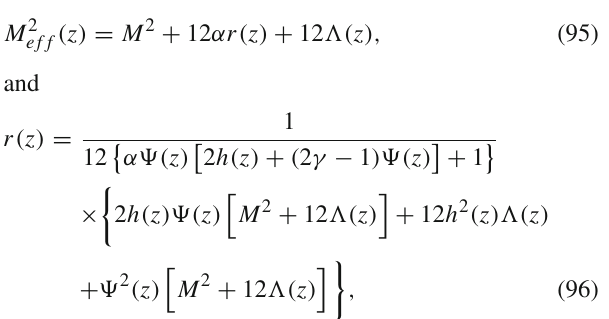
respect to z of h ( z ) . The variation of h ( z ) is relatively